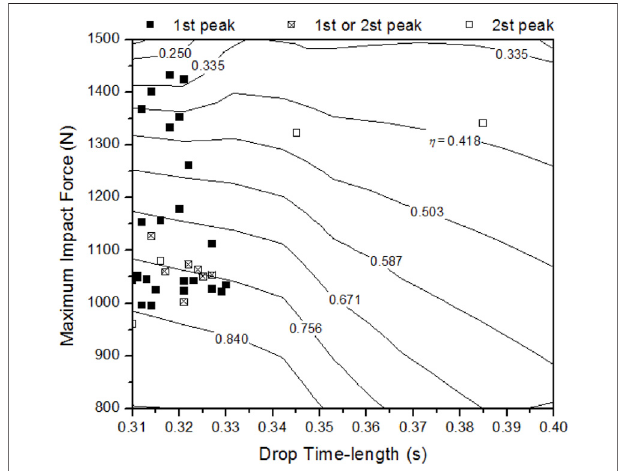
FIGURE 18 | The isogram of buffering performance evaluation factor and cases scatter in